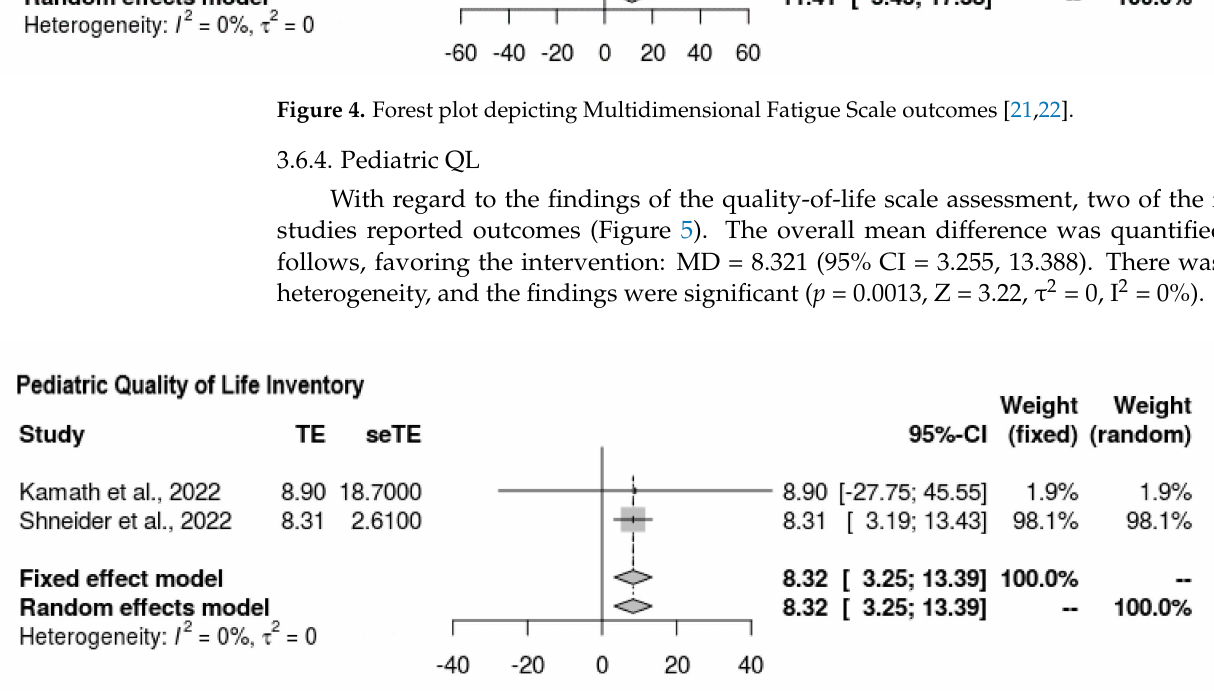
Figure 5. Forest plot depicting PedsQL score outcomes